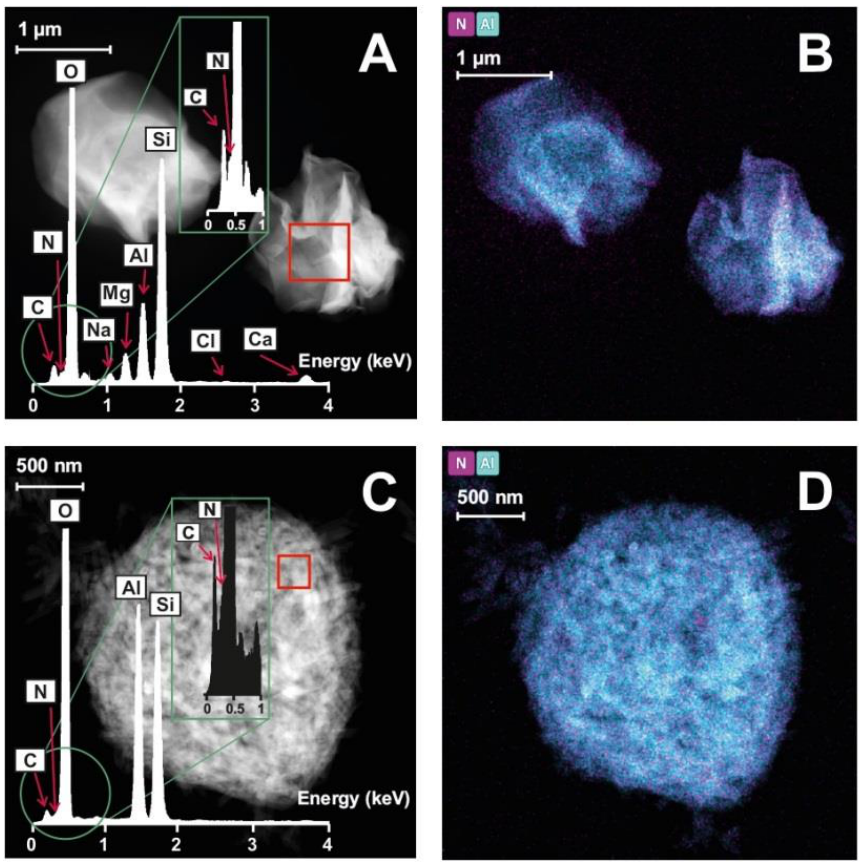
Figure 8. UHR-TEM microphotographs with EDX spectra and elemental maps of CHX – BEN SD ( A and B , respectively) and CHX – HAL SD ( C and D , respectively).